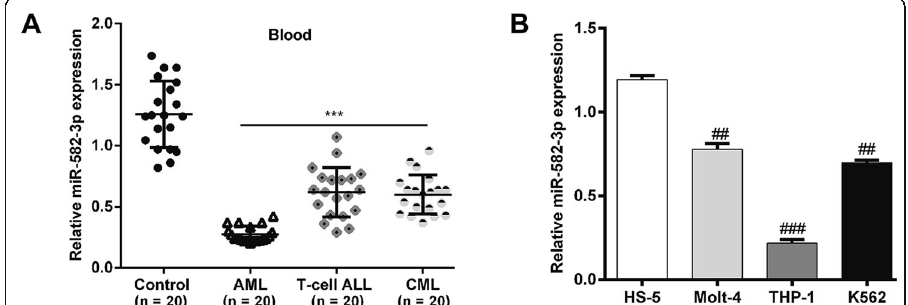
Fig. 1 Relative miR-582 – 3p expression at the mRNA level in blood samples from leukemia patients and leukemia cell lines. a The expression of miR-582 – 3p was determined in fresh blood samples from patients with acute myeloid leukemia (AML; n = 20), T-cell acute lymphoblastic leukemia (T-cell ALL; n = 20) and chronic myeloid leukemia (CML; n = 20) using quantitative real-time PCR with U6 as the internal control. b The expression of miR-582 – 3p was determined in 3 leukemia cell lines (THP-1, Molt-4 and K562) and in normal HS-5 cells using quantitative real-time PCR with U6 as the internal control. *** p < 0.001 vs. controls; ## p < 0.01, ### p < 0.001 vs. HS-5